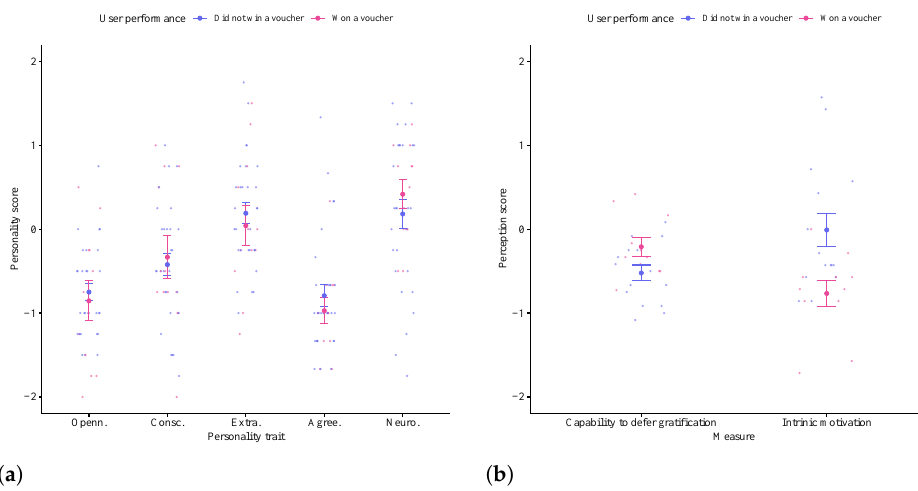
Figure 7. Mean plots per participants that either did, or did not win a voucher of: ( a ) self-reported personality scores (pre-tested participants, N = 41), and perceived deferment of gratification, ( b ) per- ceived intrinsic motivation (post-tested participants, N =